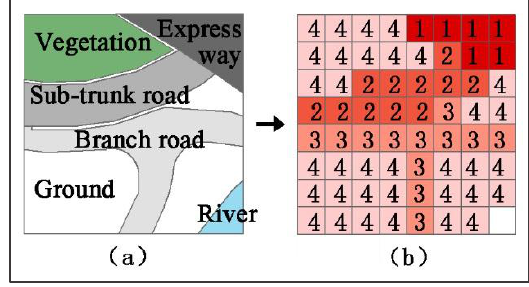
Figure 3. Methods and Procedures 1: ( a , b ) Generating an Accessibility Cost Raster. Table 3. Time Cost of Transportation Elements.